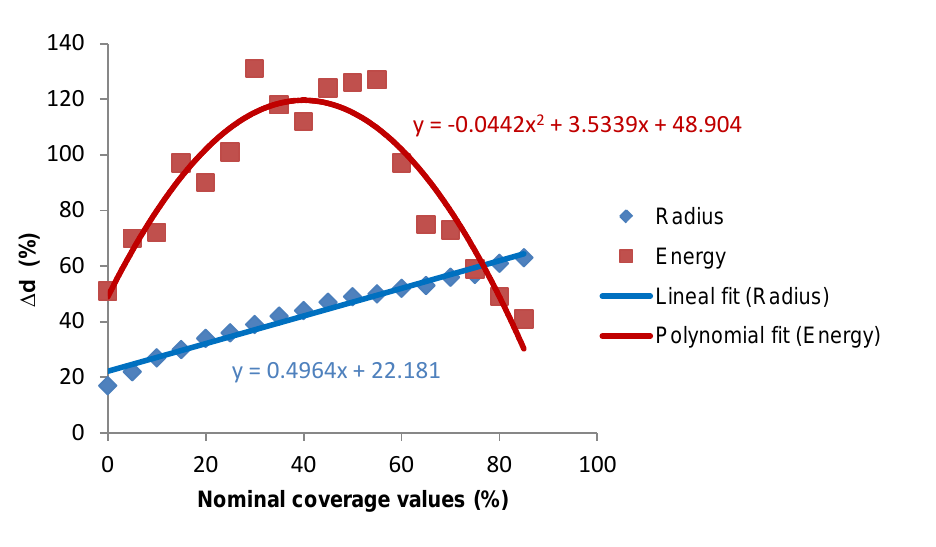
Figure 14. Radius and energy obtained for the different printing plates.